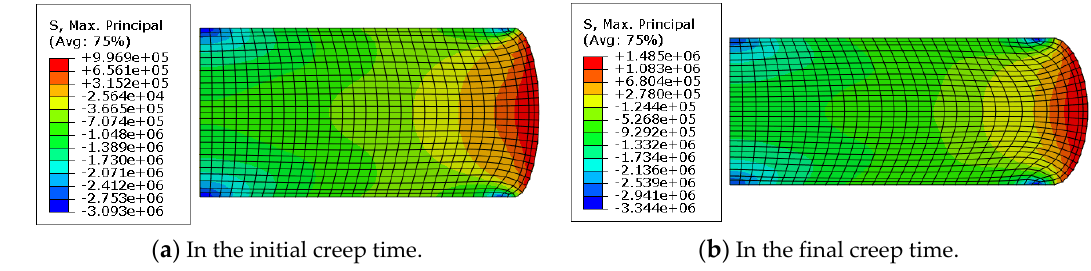
Figure 14. Maximum principle stress profiles ( T = 23 °C; F = 2.5 kN).